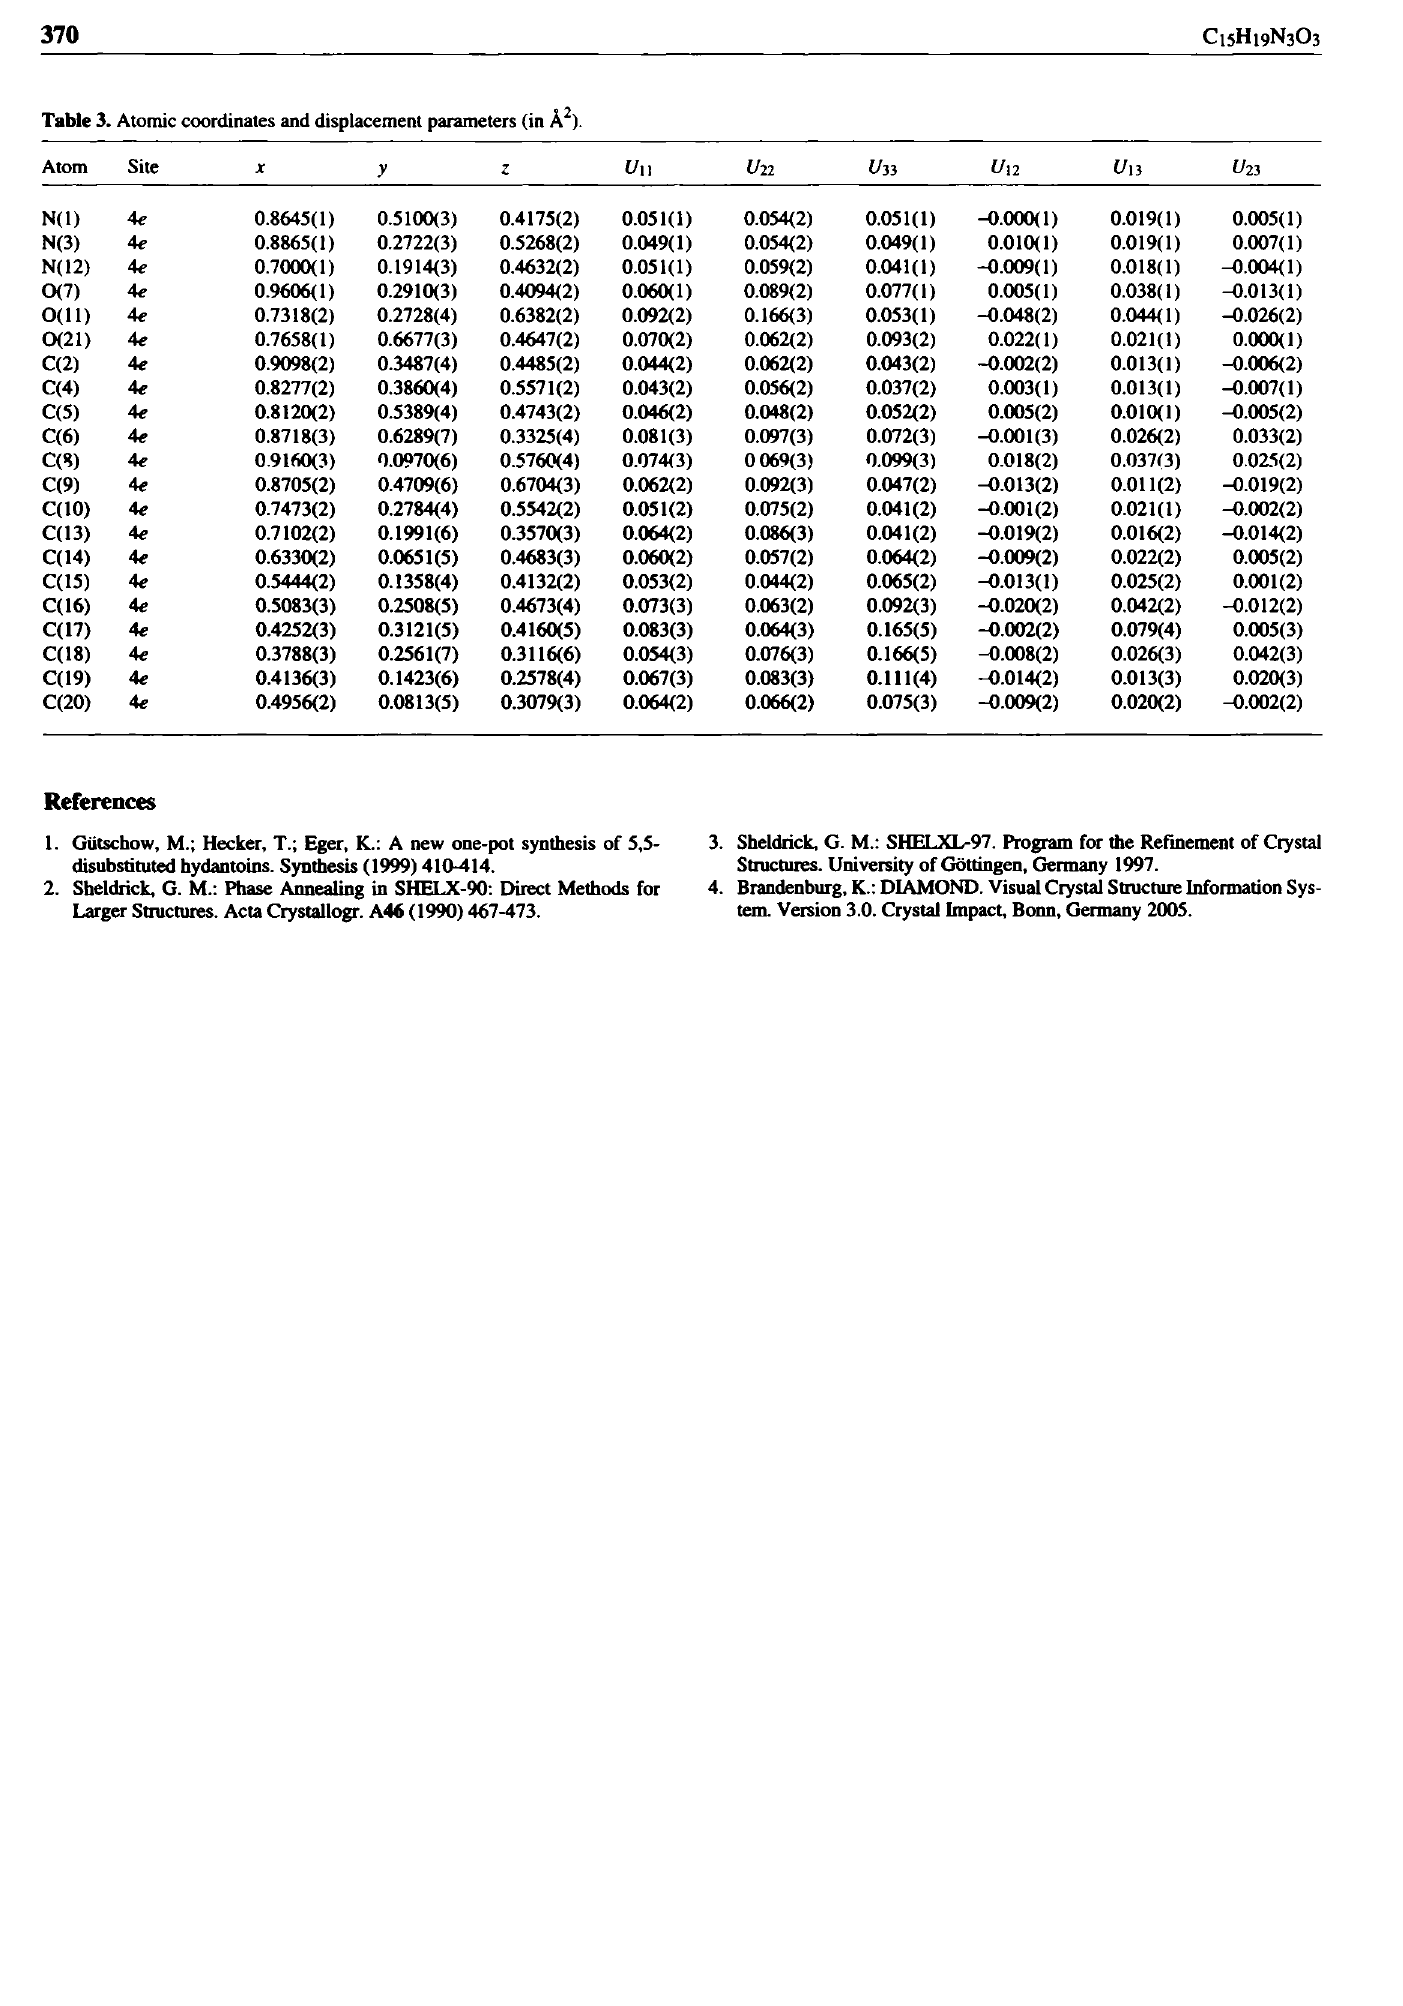
Table 3. Atomic coordinates and displacement parameters (in Ä 2